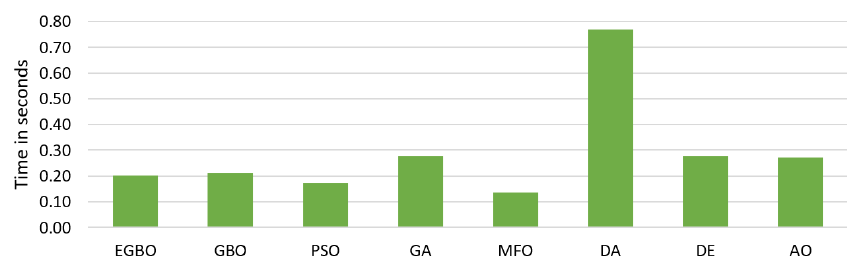
Figure 2. Average computation times for all methods in all